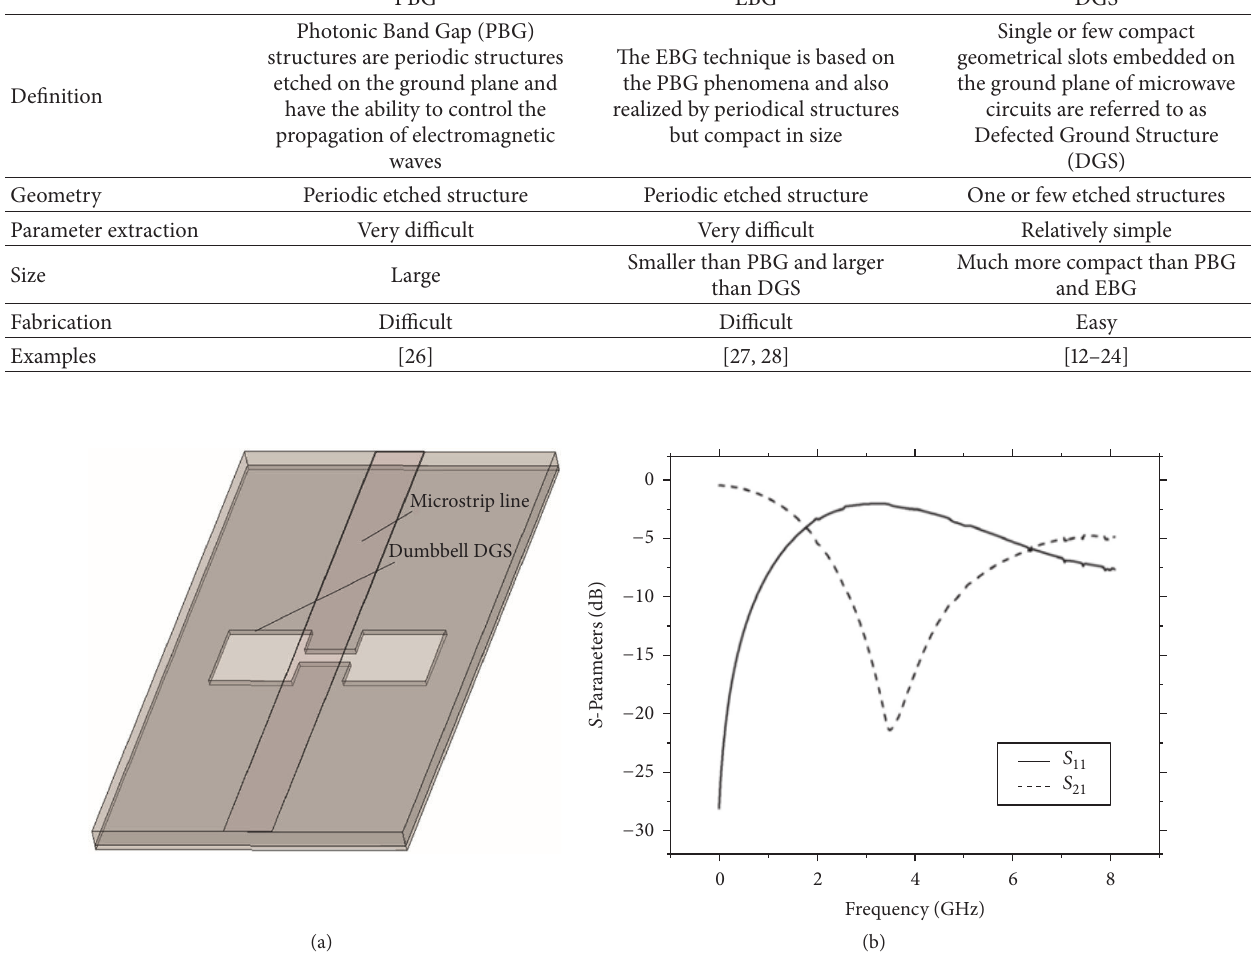
Figure 1: The first DGS unit: (a) dumbbell DGS unit; (b) simulated 𝑆 -parameters for dumbbell DGS unit